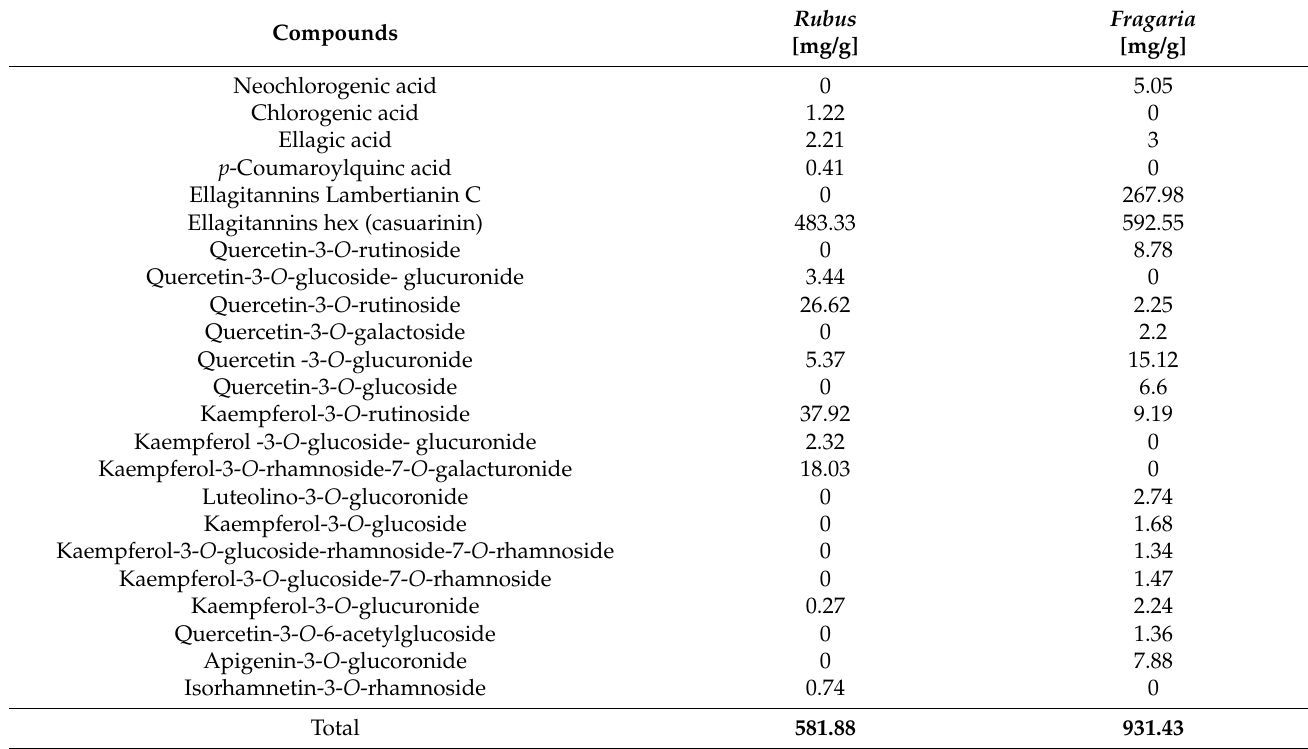
Rubus Fragaria [mg/g] [mg/g]